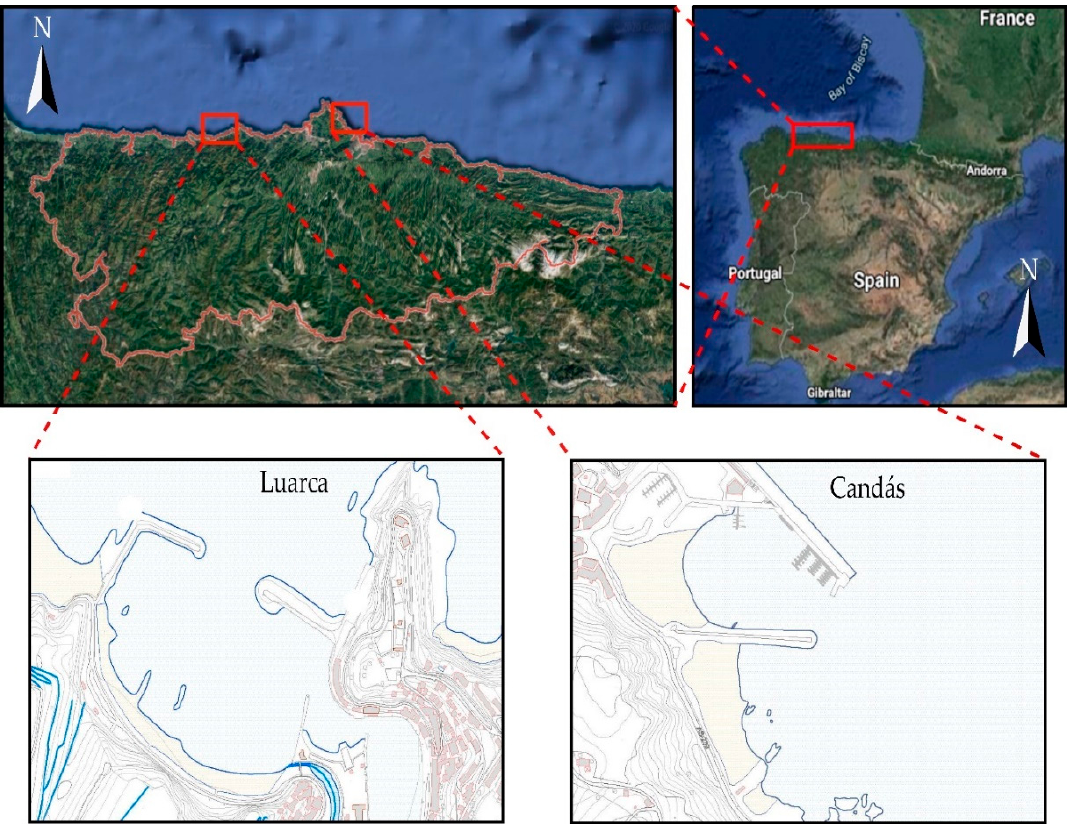
Figure 1. Study site locations in Spain coastal waters. Port of Candás (43°35’25 ″ N to 5°45’43 ″ W) and Port of Luarca (43°32’45 ″ N to 6°32’1 ″ O).